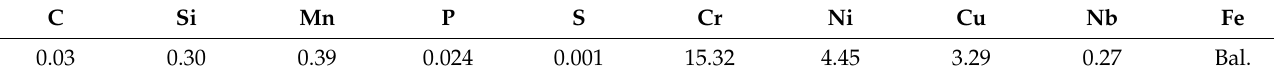
Table 1. Chemical composition of the studied 17-4PH steel (wt%).